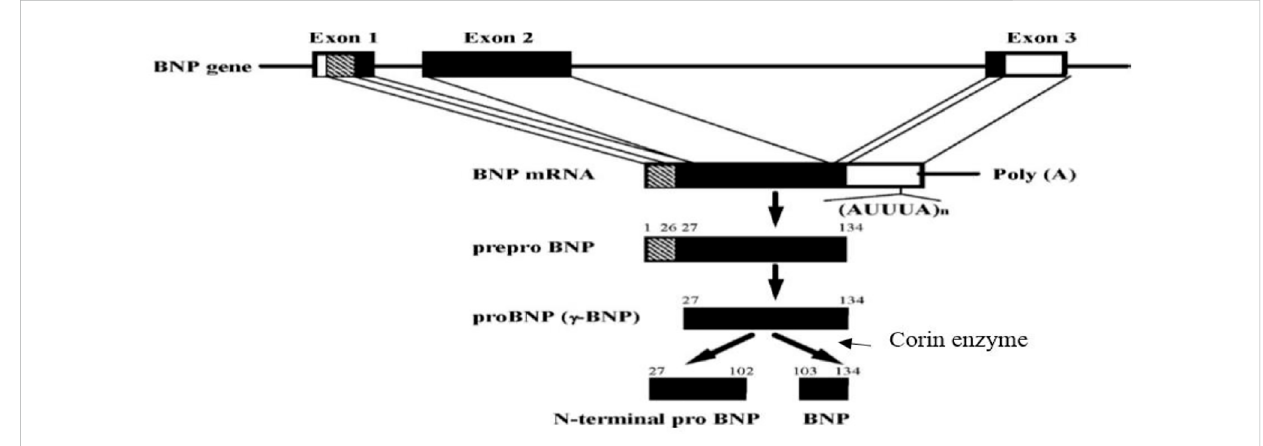
FIGURE 1 Chemical structure and production processing of BNP 1-32 and NT-pro-BNP 1-76